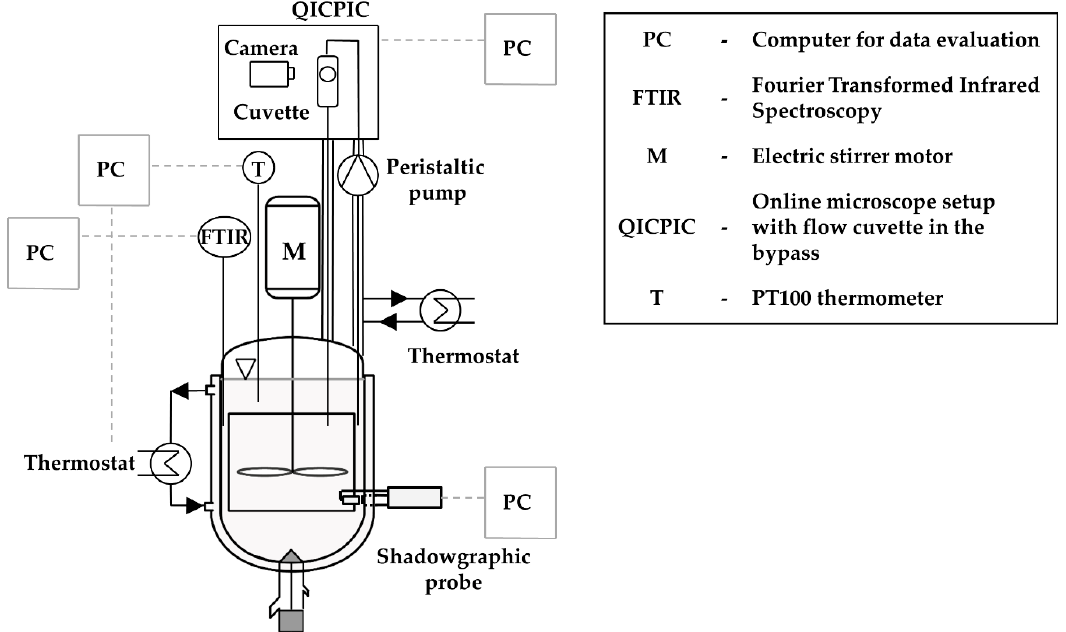
Figure 2. Scheme of the 25 L utilized double jacket draft tube crystallizer setup [62].